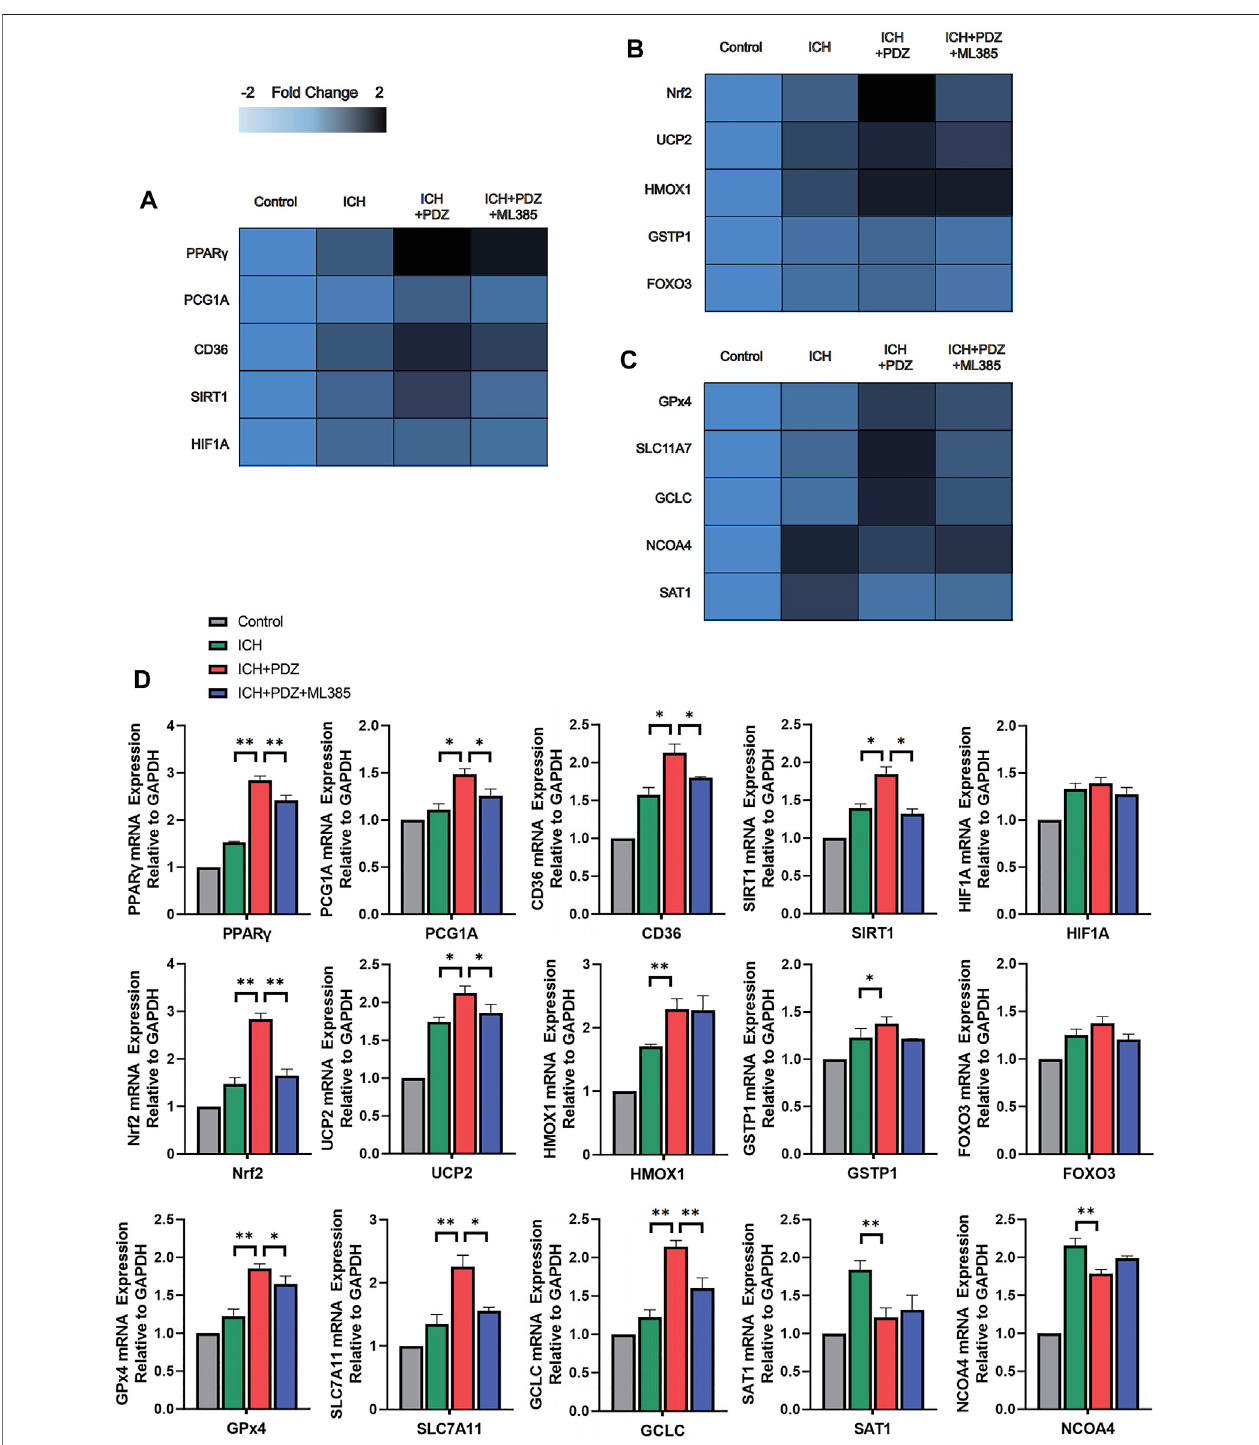
FIGURE6 | Effects ofPPAR γ activators on PPAR γ -, Nrf2-and Gpx4-related pathways. At7 days after ICH, the expression of thetargetgenes wasdetected using RT – qPCRandcomparedwiththatofaninternalreferencegene(GAPDH),andanimproveddelta-delta-CTalgorithmwasused. (A) HeatmapofthemRNAabundanceof genesinthePPAR γ signaling pathway. (B) Heatmap ofthemRNAabundance ofgenesintheNrf2signalingpathway. (C) Heatmap ofthemRNA abundanceofgenesin the Gpx4 signaling pathway. (D) Detailed comparison of PCR results for each gene. Dataare shown as the means ± SD of n = 3 samples/group, and at least three independent experiments were performed. Statistical analyses were conducted using two-way ANOVA followed by the Newman-Keuls multiple-comparison post hoc test. * p < 0.01, ** p < 0.01.